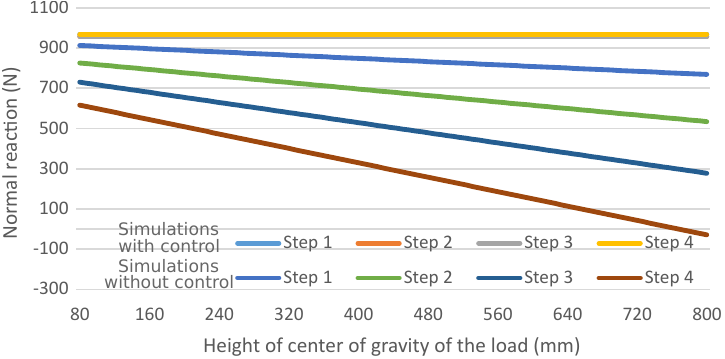
Figure 14. Variation of normal reaction on rear wheel with respect to change in height of the center of gravity of the load.